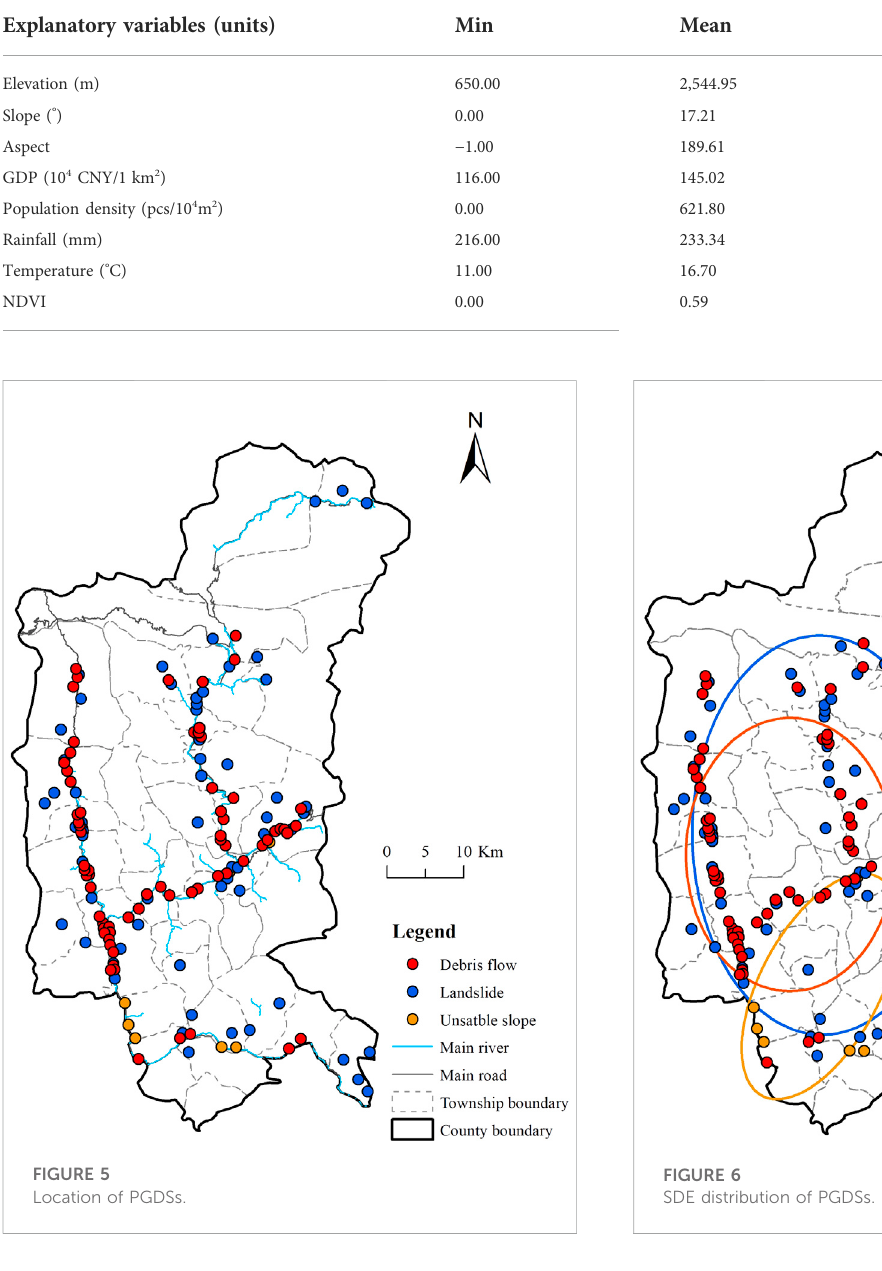
TABLE 2 Descriptive statistics of explanatory variables.